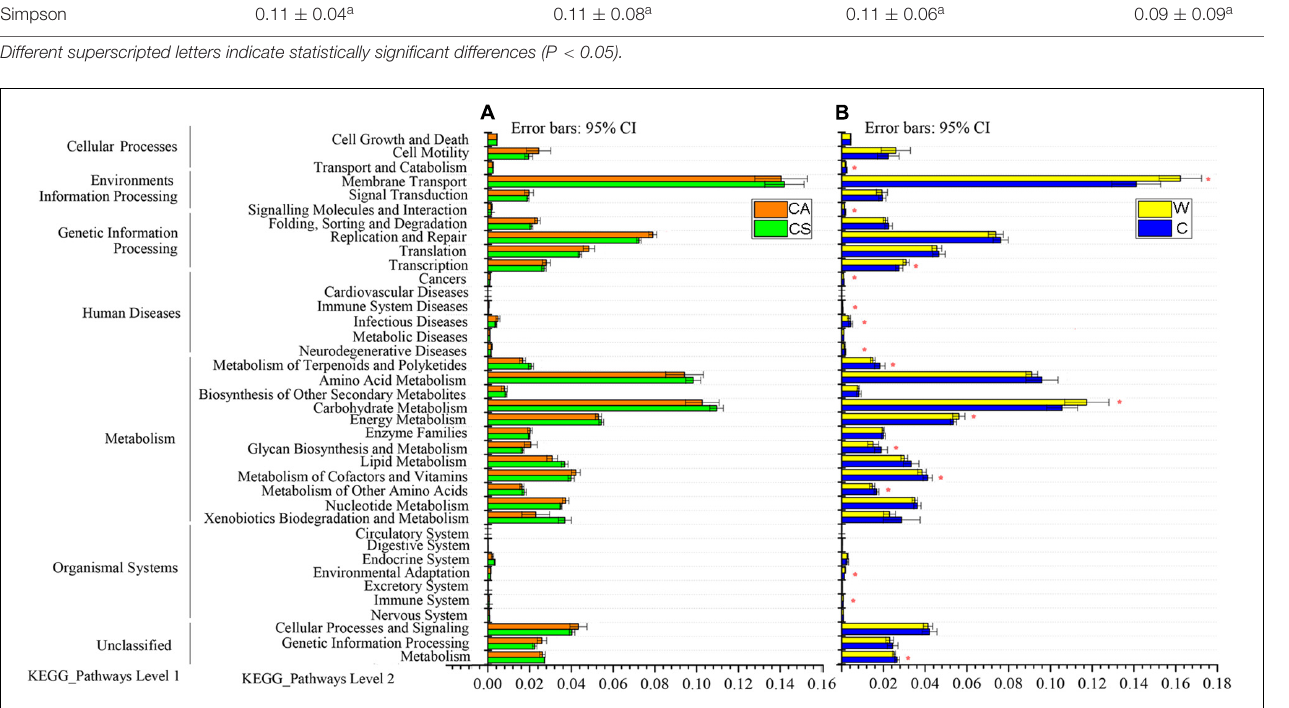
frogs, and Lachnospiraceae (24.21 vs. 13.66% in captive frogs) and Ruminococcaceae (22.84 vs. 6.46% in captive frogs) were the most abundant families in wild frogs ( Figure 2C